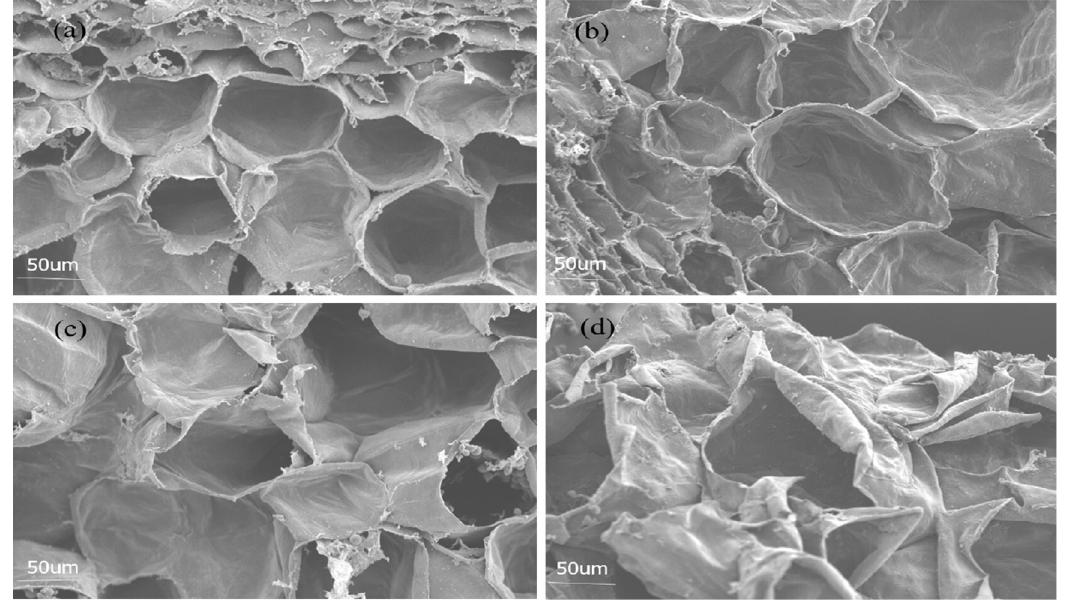
Figure 2. Effects of sunburn on cell structure. ( a ) Debagged fruits, normal (BFN), ( b ) non-bagged fruits (NBF), ( c ) debagged fruits with albefaction (BFA), and ( d ) debagged fruits with browning (BFB).